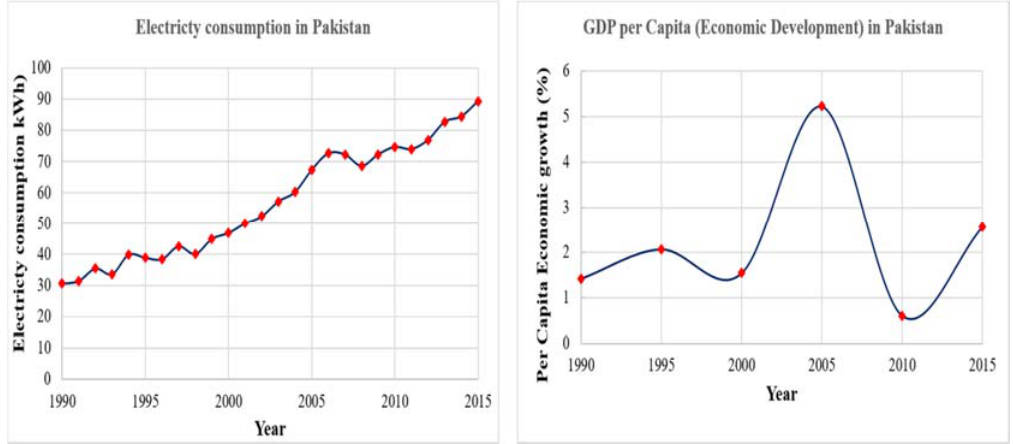
Figure 2. Electricity supply and GDP per capita in Pakistan.